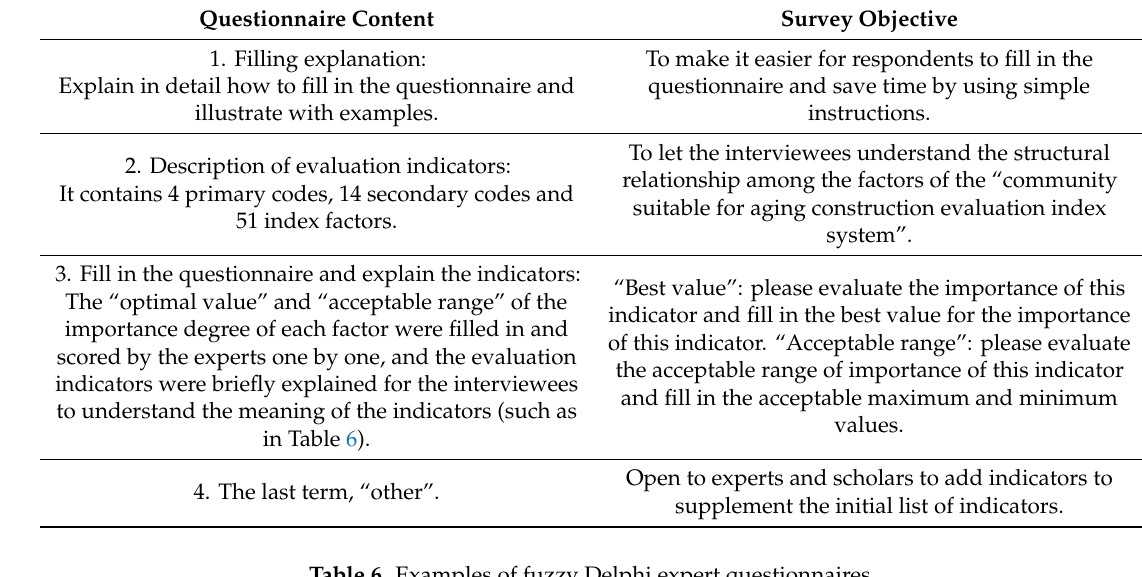
Table 6. Examples of fuzzy Delphi expert